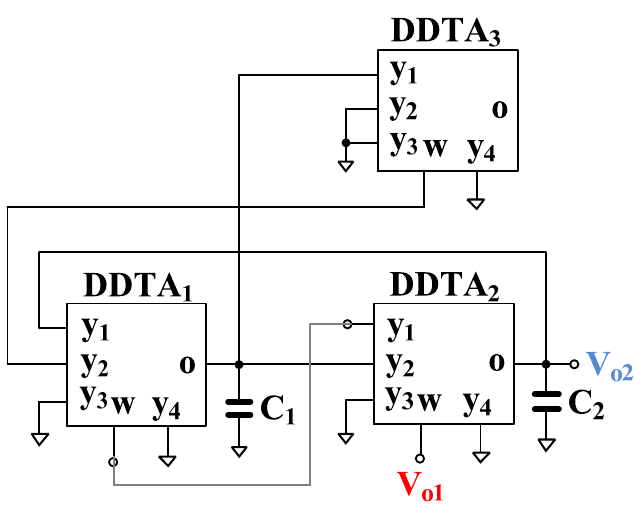
Figure 6. Modified quadrature oscillator.